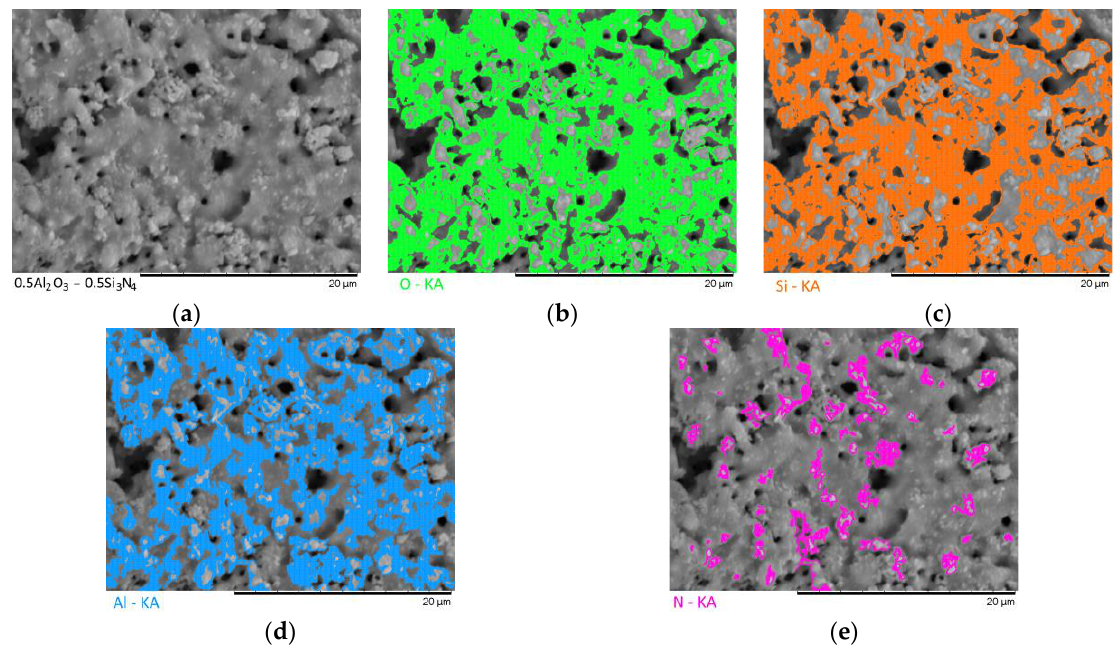
Figure 3. Results of morphological studies and mapping of a ceramic sample with an Al 2 O 3 content of 0.5 mol: ( a ) SEM image; ( b ) oxygen distribution results; ( c ) silicon distribution results; ( d ) aluminum distribution results; ( e ) nitrogen distribution results.